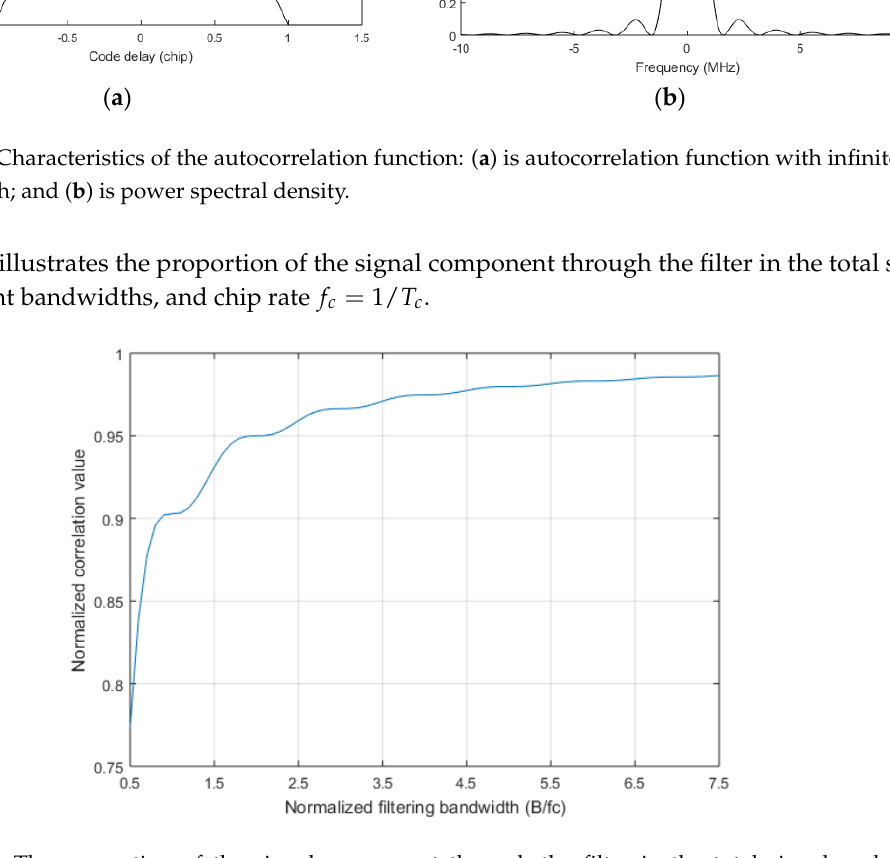
Figure 5. The proportion of the signal component through the filter in the total signal under different bandwidths.